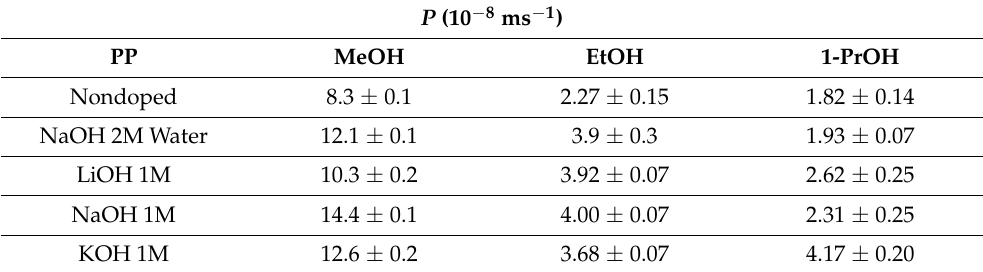
Table 4. Alcohol permeability values for nondoped PP membrane and doped under different conditions.